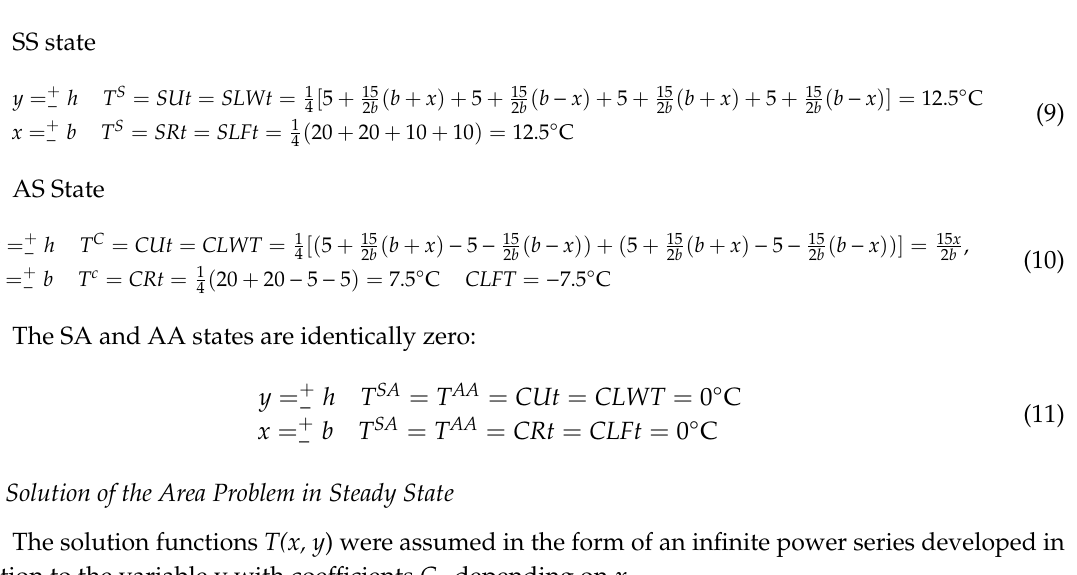
Figure 5. Antisymmetric part relative to x and symmetric to y . AS state.